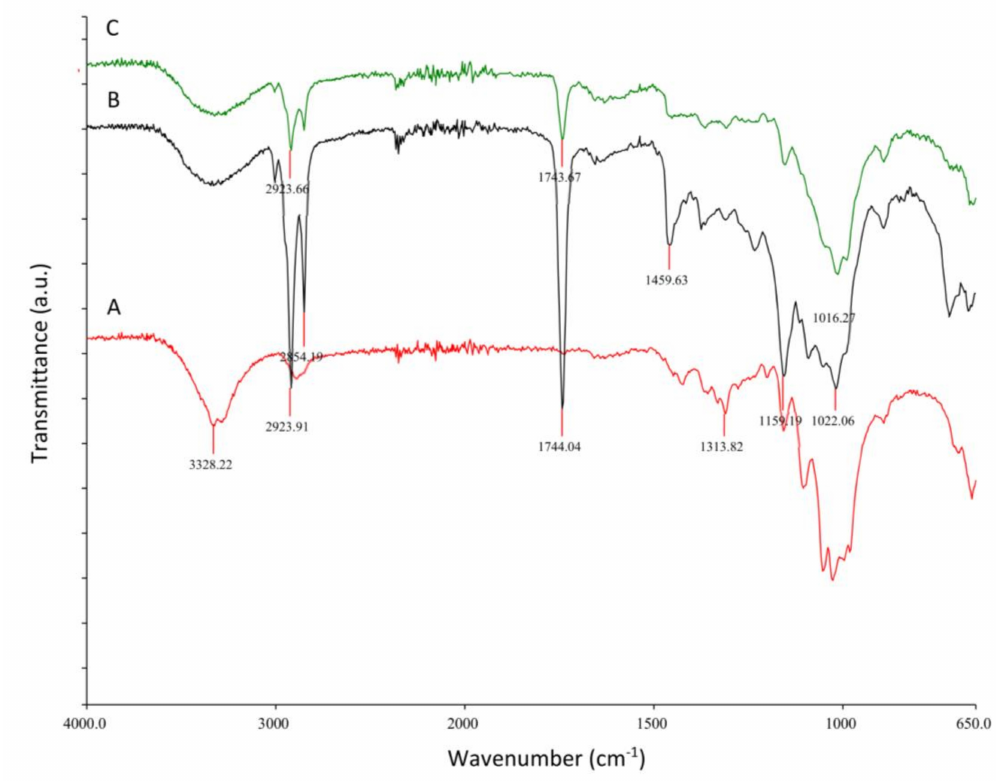
Figure 4. ATR FTIR spectrum of non-treated viscose tampon ( A red), spectrum of CBD liposome functionalized viscose tampon on outer side ( B black), and spectrum of CBD liposome functionalized viscose tampon on inner side ( C